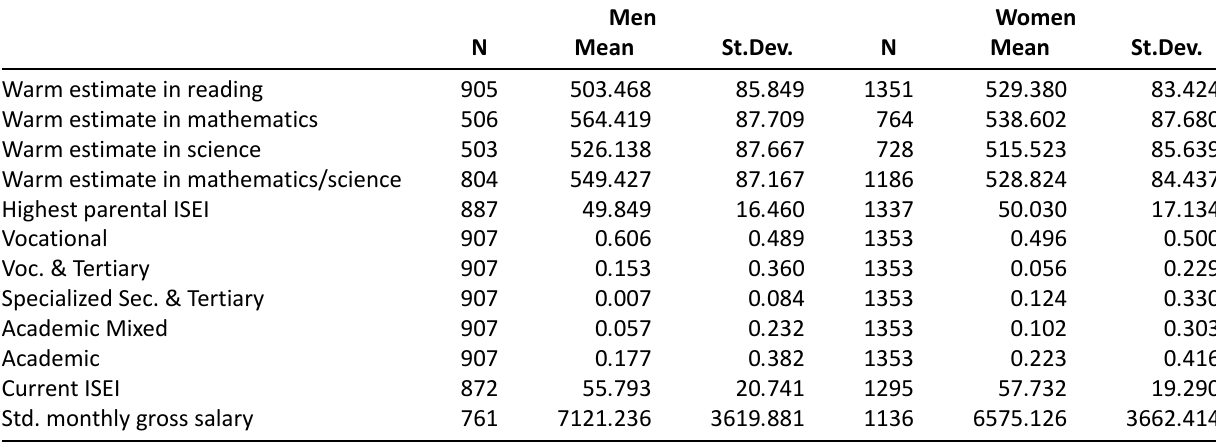
Table 1. Descriptive statistics. Source: PISA (2000) and TREE waves 1–9 (weighted;